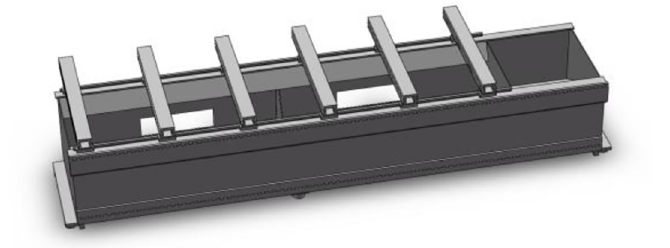
Fig 4. Bed simplified 3D solid model.